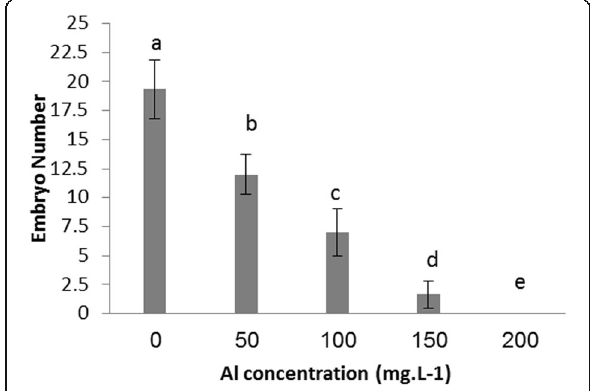
Fig. 3 Al toxicity on embryo number of date palm callus